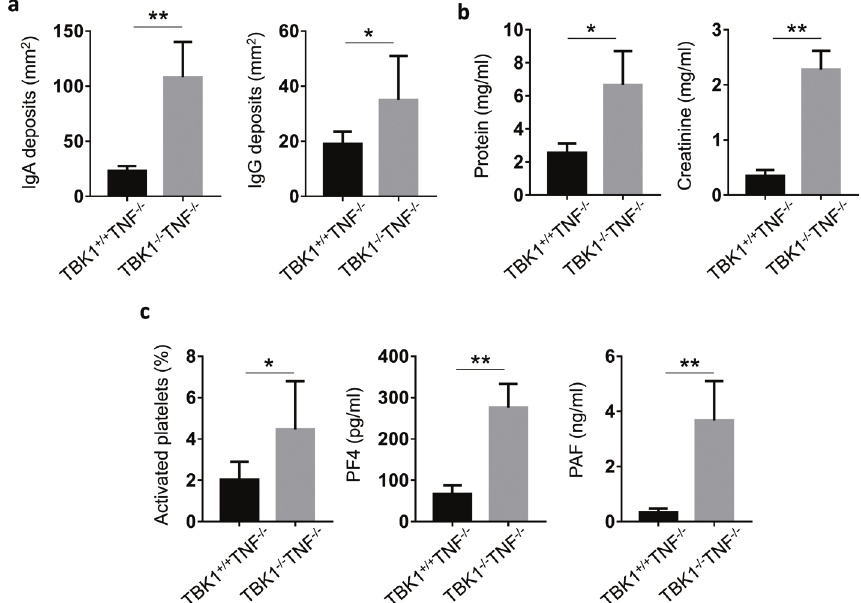
Fig. 2 . Tbk1 -/- TNF -/- mice displayed the symptoms of IgA nephropathy. (a) The deposition of IgA and IgG in glomeruli of wild- type (WT) and TBK1 -/- TNF -/- mice were quantified. (b) Urinary protein and serum creatinine in WT and TBK1 -/- TNF -/- mice were measured by ELISA. (c) The protein levels of PF4 and PAF in the serum from WT and TBK1 -/- TNF -/- mice were assessed by ELISA. The data were expressed as means ± standard error of mean (SEM). Results represent the mean values of three inde- pendent experiments. *, P < 0.05; **, P < 0.01; ***, P <